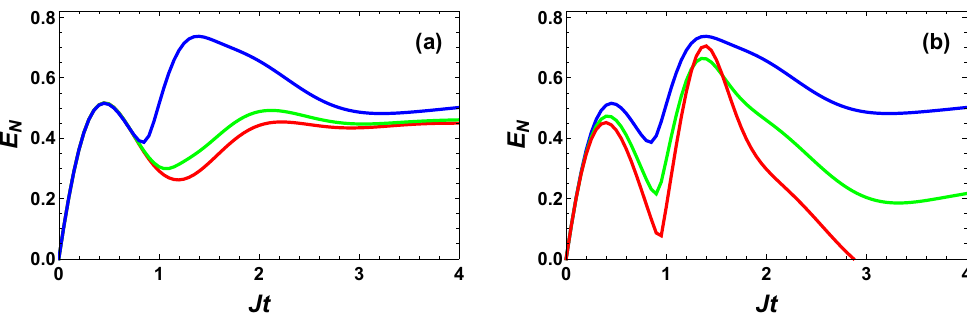
Figure 4. Time evolution of the logarithmic negativity for the coupled microresonators driven by a coherent field. In ( a ), the system parameters are γ / J = 0.8, G 0 = 0.8, I sat = 0.05, and E 0 / J = 0.9 (blue), 0.7 (green), and 0.1 (red). In ( b ), the saturation intensity is changed to I sat = 0.05 (blue), I sat = 0.3 (green), I sat = 0.7 (red), while the ratio E 0 / J = 0.9 is